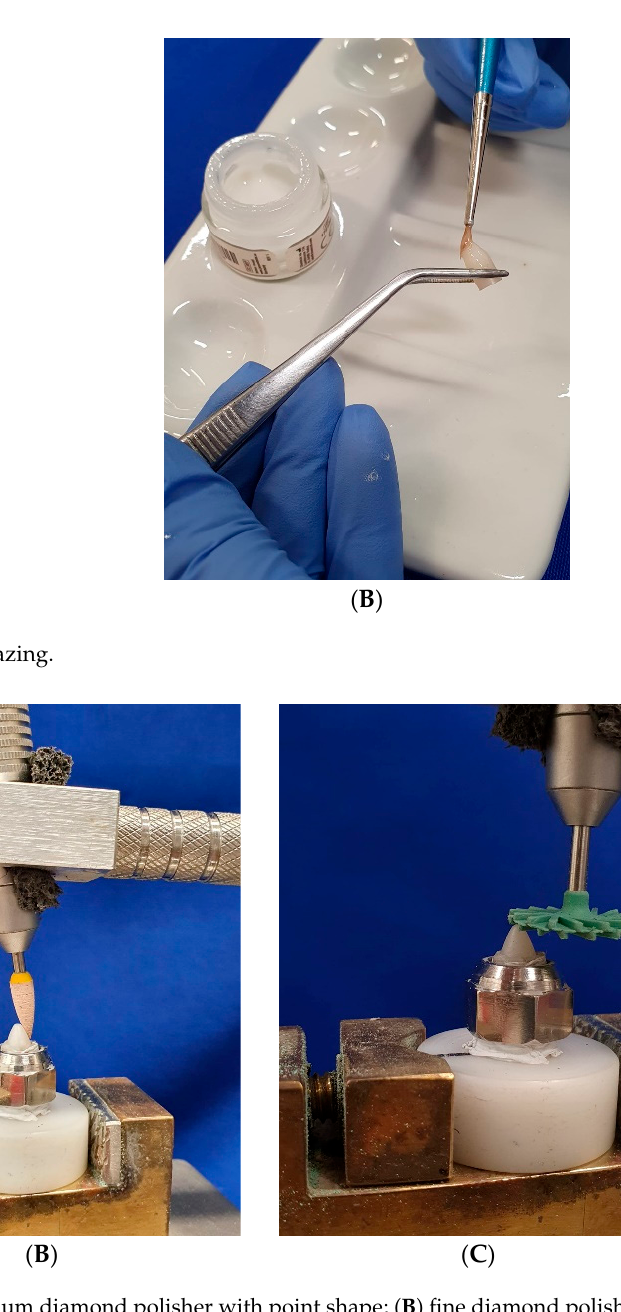
Figure 3. Polishing. ( A ) Medium diamond polisher with point shape; ( B ) fine diamond polisher with point shape; ( C ) medium diamond polisher with twist shape.